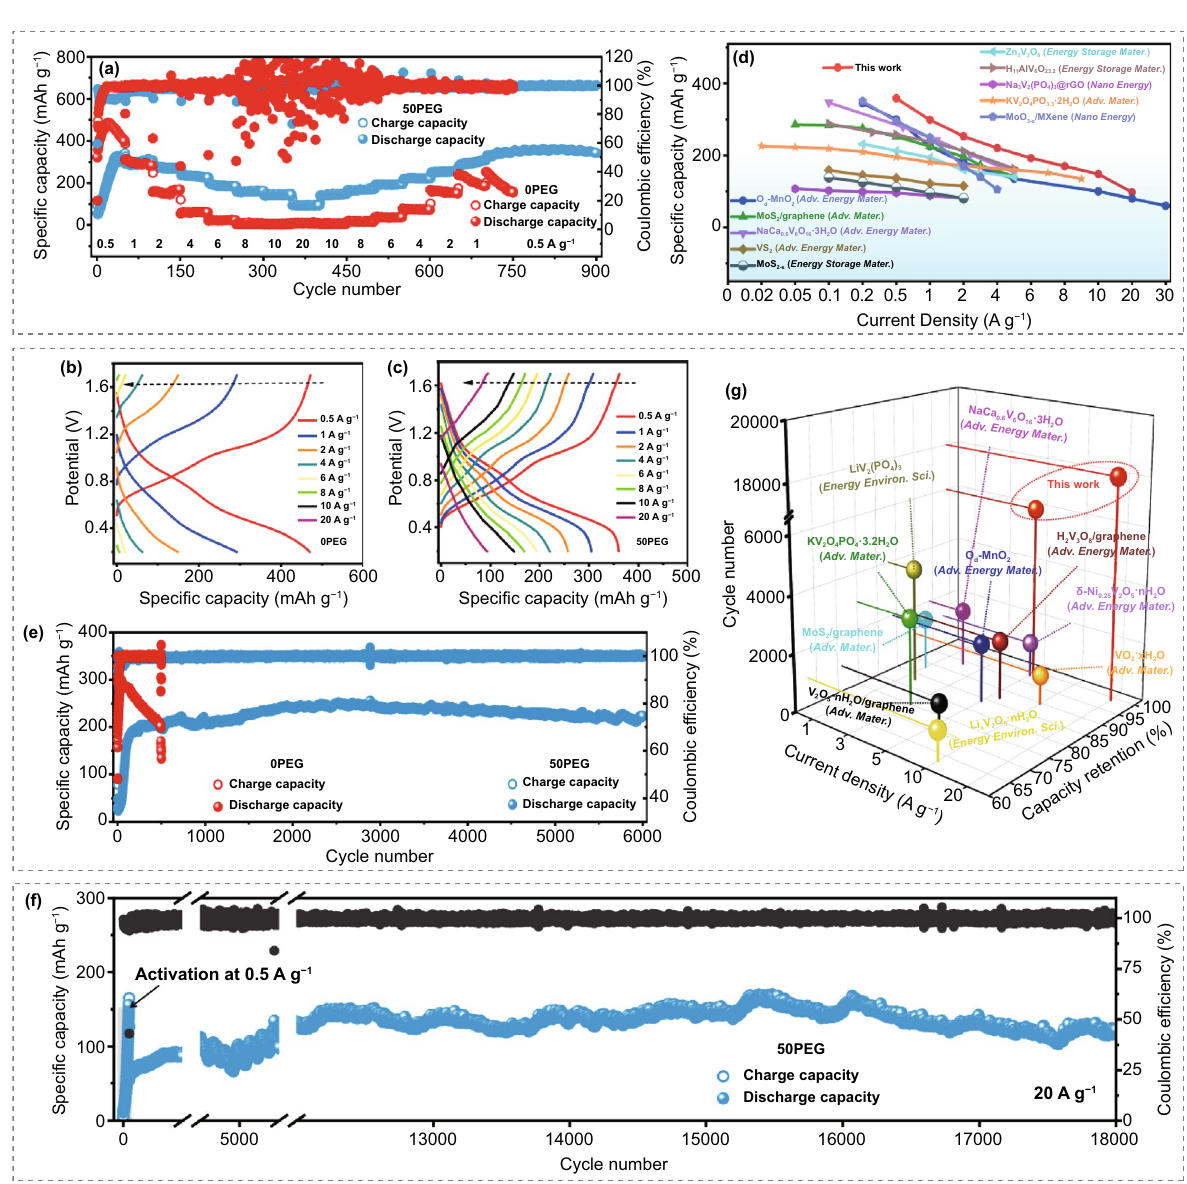
Fig. 3 Electrochemical performance of the V 2 O 3 /C cathode. a Rate performance test and ( b , c ) corresponding charge–discharge curves at dif- ferent current densities. d The comparison of rate performance between this work and other previous works. Cyclic stability test at the current density of e 5 A g −1 and f 20 A g −1 , respectively. g The comparison of cyclic stability between this work and other previous